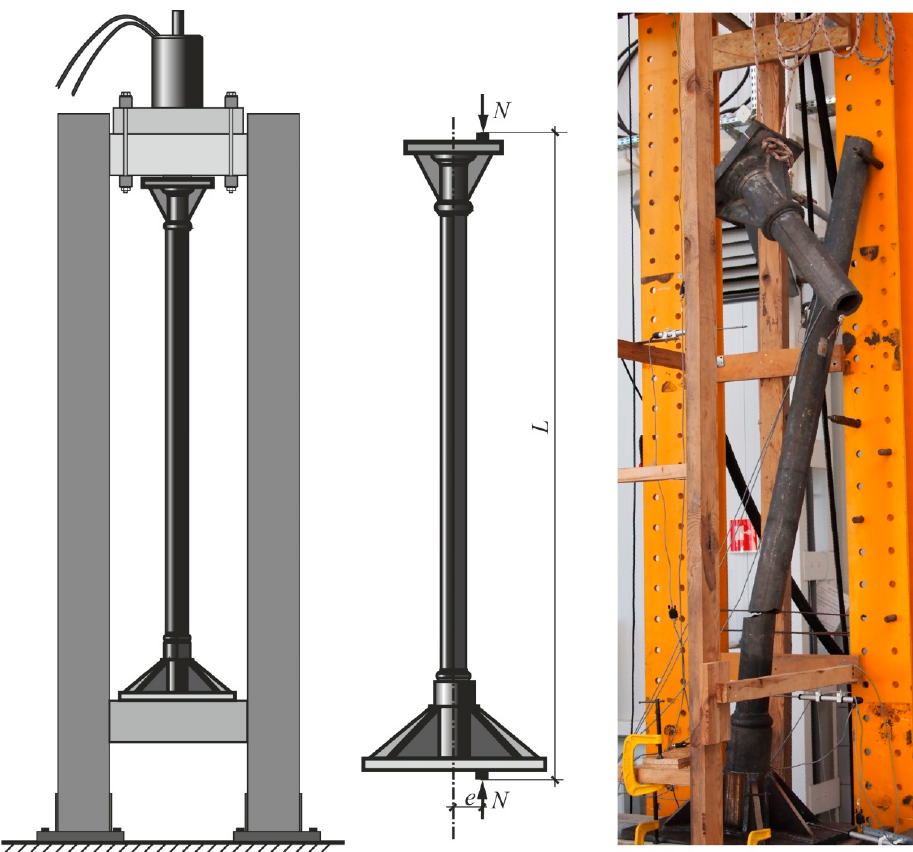
Figure 1. The schematic diagram of the stand and column’s destruction during the test.